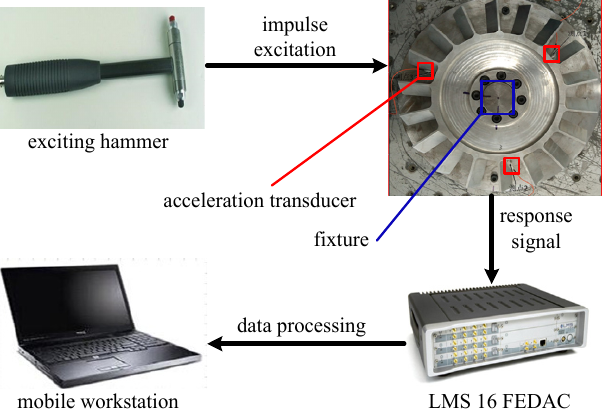
Figure 4. Picture of the mistuned blisk and experimental devices. FEDAC, front-end data acquisition controller.